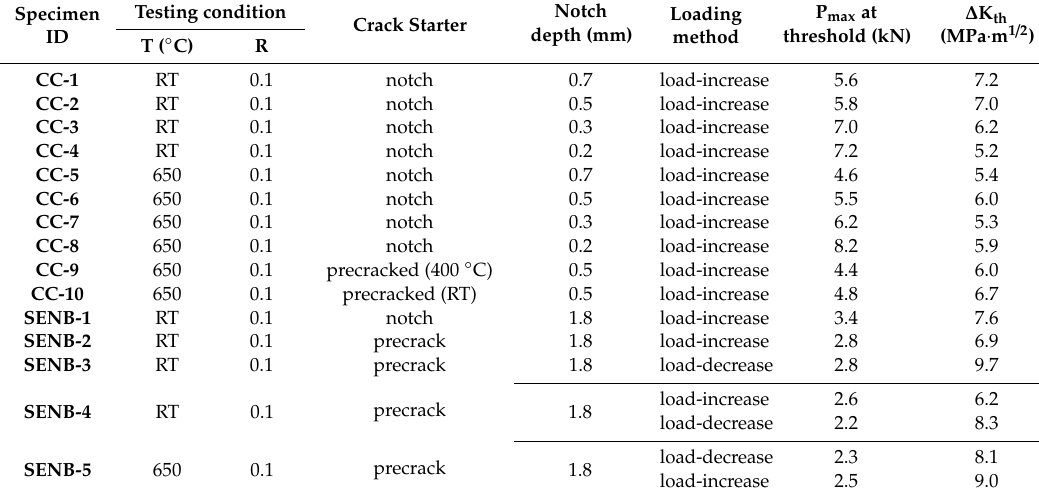
Table 2. Summary of fatigue threshold and crack growth tests in SENB and CC specimens, including fatigue crack starter, loading methods, maximum load at threshold, and fatigue threshold